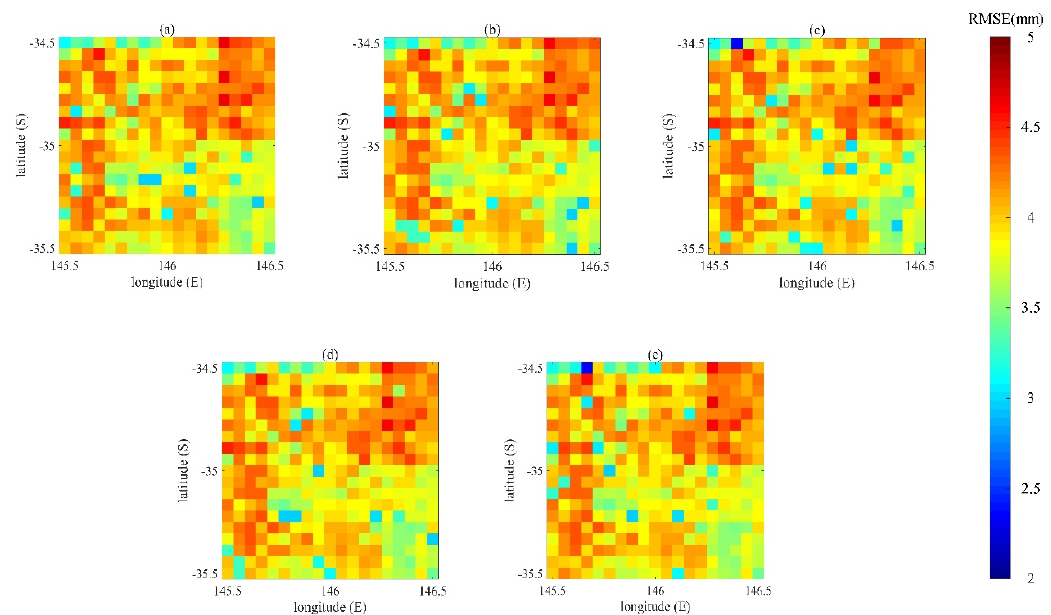
Figure 6. The RMSE values between the CCI data and the assimilated data with ensemble sizes of: ( a ) 20; ( b ) 50; ( c ) 100; ( d ) 200; and ( e ) 500.